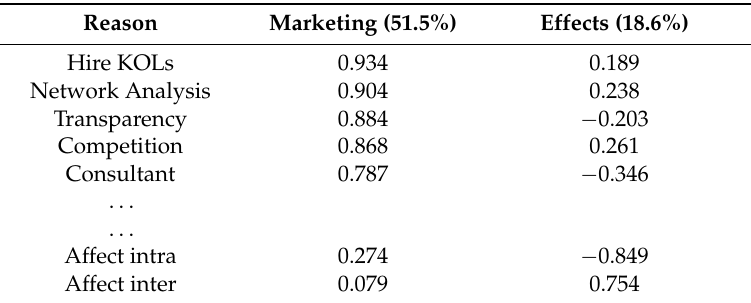
Table 1. Major factors identified in factor